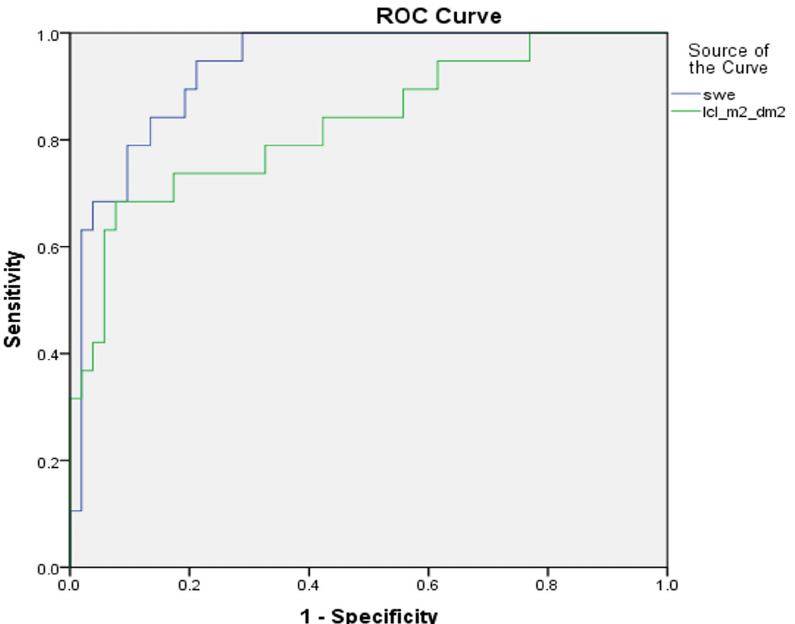
Figure 4. ROC curves of 2D-SWE and dynamic liver scintigraphy, with 99mTc-mebrofenin separating significant liver fibrosis; AUROC was 0.93 and 0.83, respectively ( p value 0.061). swe—2D-SWE value represented in kPa; lcl_m 2 _dm 2 —liver clearance measured in the right liver lobe and corrected using BSA and LA. In separating advanced liver fibrosis/liver cirrhosis (F1–F3 versus F4), we found an 85% sensitivity and 85% specificity for 2D ‐ SWE, and a 90% sensitivity and 87% specificity for dynamic liver scintigraphy with 99mTc ‐ mebrofenin. The AUROC was 0.91 and 0.96, respectively ( p value 0.33) (Figure 5).